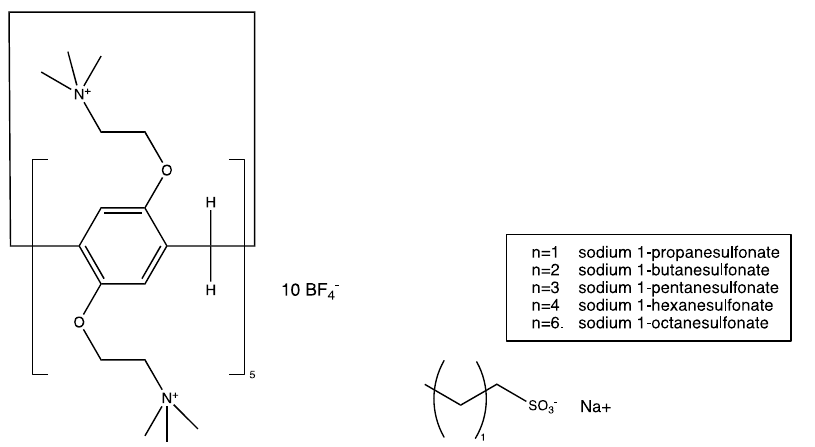
Scheme 1. Catio % nic pillar[5]arene and